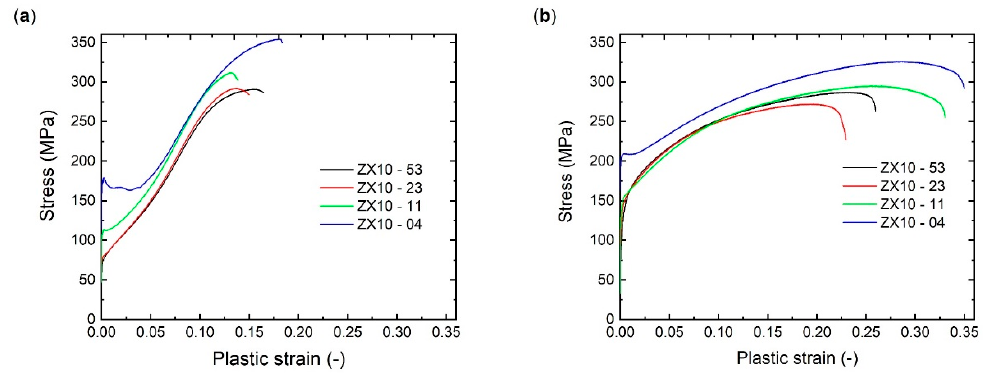
Figure 3. Compressive ( a ) and tensile ( b ) deformation behaviour of the extruded ZX10 alloy with respect to the average grain size.